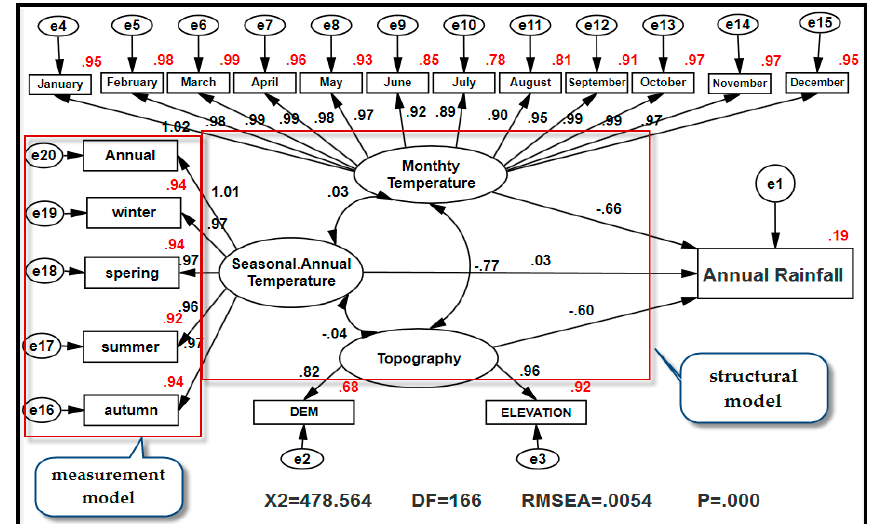
Figure 21. The effectiveness of the temperatures, elevation, and DEM on annual rainfall (final model). Measurement and structural models analyzed on annual rainfall series. The effectiveness and causality model shows that latent variables or factors (monthly temperature series, seasonal and annual temperature series and topography) have direct (negative effects) and indirect effects (negative and positive effects) on annual rainfall (0.68 < R 2 < 0.99, or 68%–99%, red data).